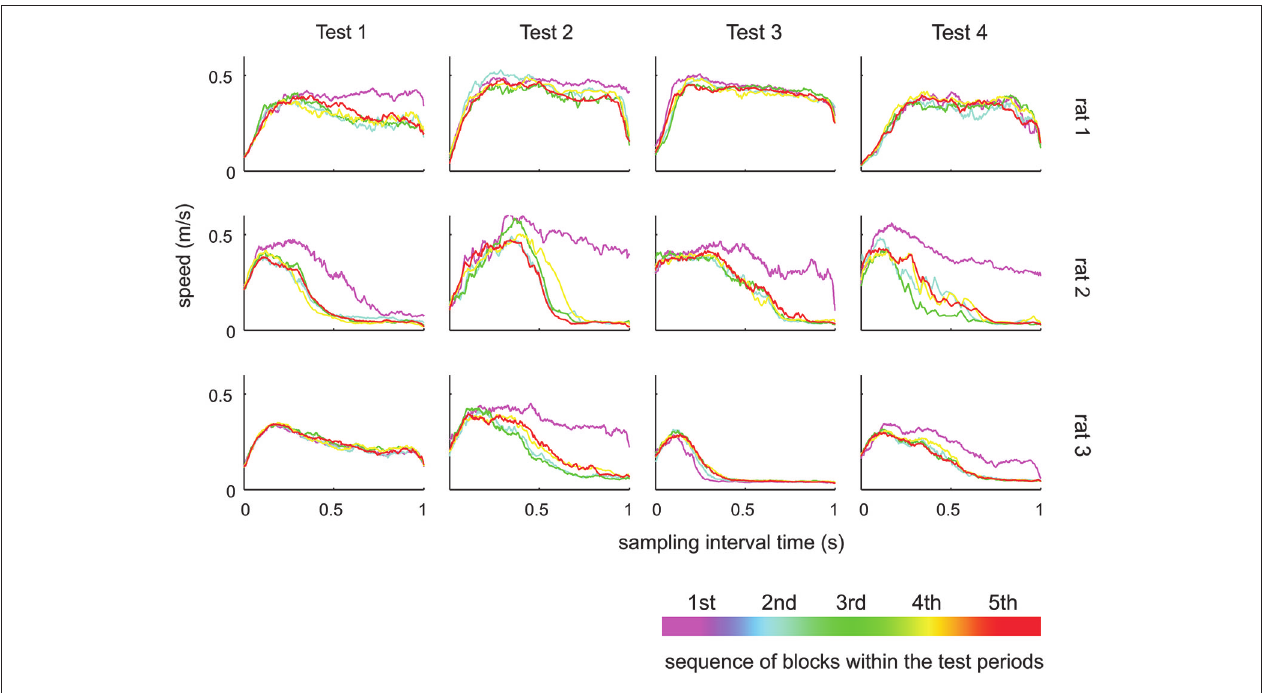
animals tended to generate higher whisker speeds. There was, however, no systematic change of whisking speeds across the